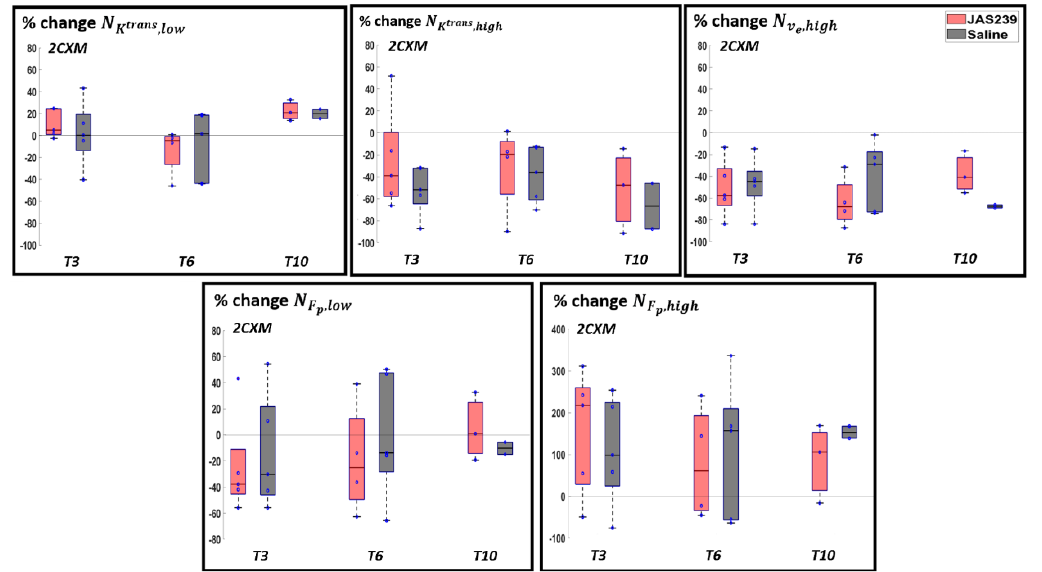
Figure 5. Box plots showing percentage change (with respect to baseline) in GL261 mice GBM with regards to the number of pixels representing the clustered parameters 𝐾 𝑡𝑟𝑎𝑛𝑠 and 𝑣 𝑒 on the top and 𝐹 𝑝 on the bottom (only the parameters that changed significantly from baseline values are shown). K ep